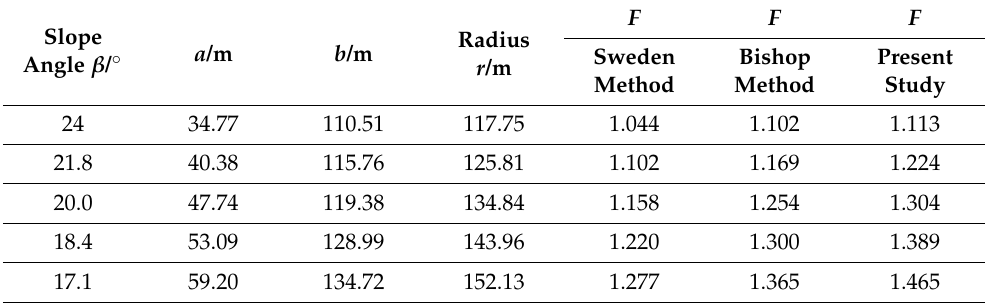
Table 1. Results of safety factor (case 1).